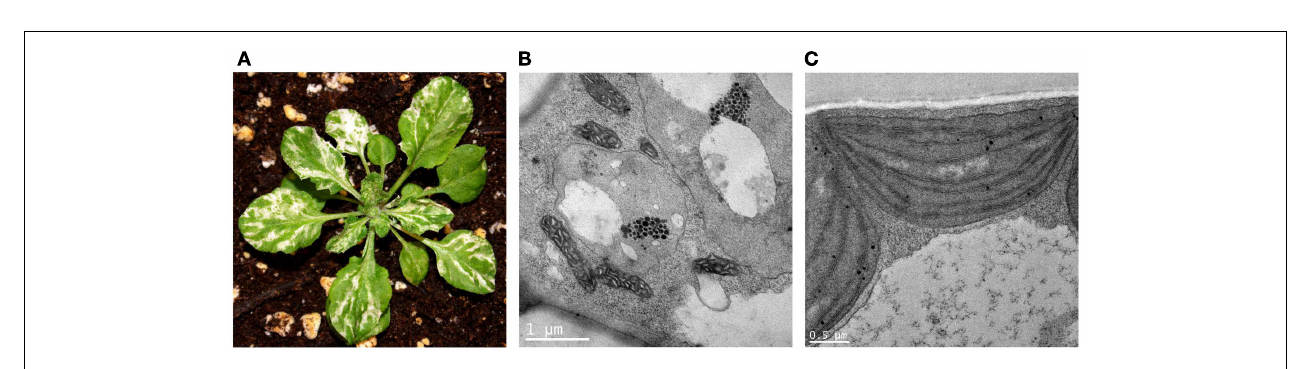
FIGURE 2 | Ultrastructural analysis of immutans (A). A representative immutans plant grown at 22˚C under continuous illumination for 7days at 5 µ mol photons m − 2 s − 1 followed by 3weeks at 100 µ mol photons m − 2 s − 1 .